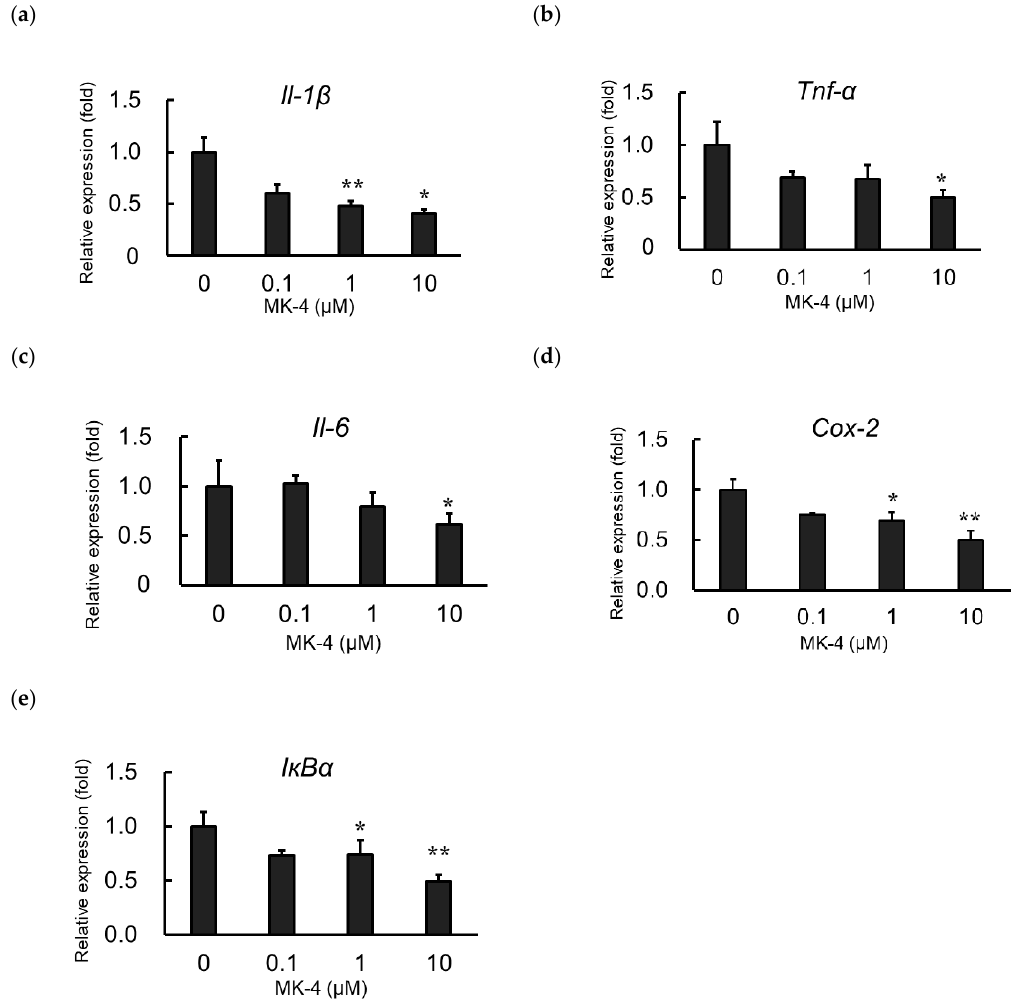
Figure 2. Menaqunine-4 (MK-4) dose-dependently suppresses inflammatory cytokine and inflammatory mediator expression. Various doses of MK-4 (0 ‒ 10 µM) were administered to MG6 cells for 24 h, and cells were subsequently exposed to LPS (1 ng/mL) for 3 h. The mRNA levels of inflammatory cytokines and inflammatory mediators were measured by quantitative reverse transcriptase-PCR, normalized to levels of Eef1a1 (the internal standard), and expressed as the fold-change relative to control cell values (cells not treated with MK-4). ( a – c ) The mRNA levels of proinflammatory cytokines Il-1 β ( a ), Tnf- α ( b ), and Il-6 ( c ). ( d , e ) mRNA levels of proinflammatory mediators: Cox-2 ( d ) and I κ B α ( e ). Data are presented as the mean ± S.E.M, n = 3. Values were significantly different from those of the control at * p < 0.05 and ** p < 0.01.